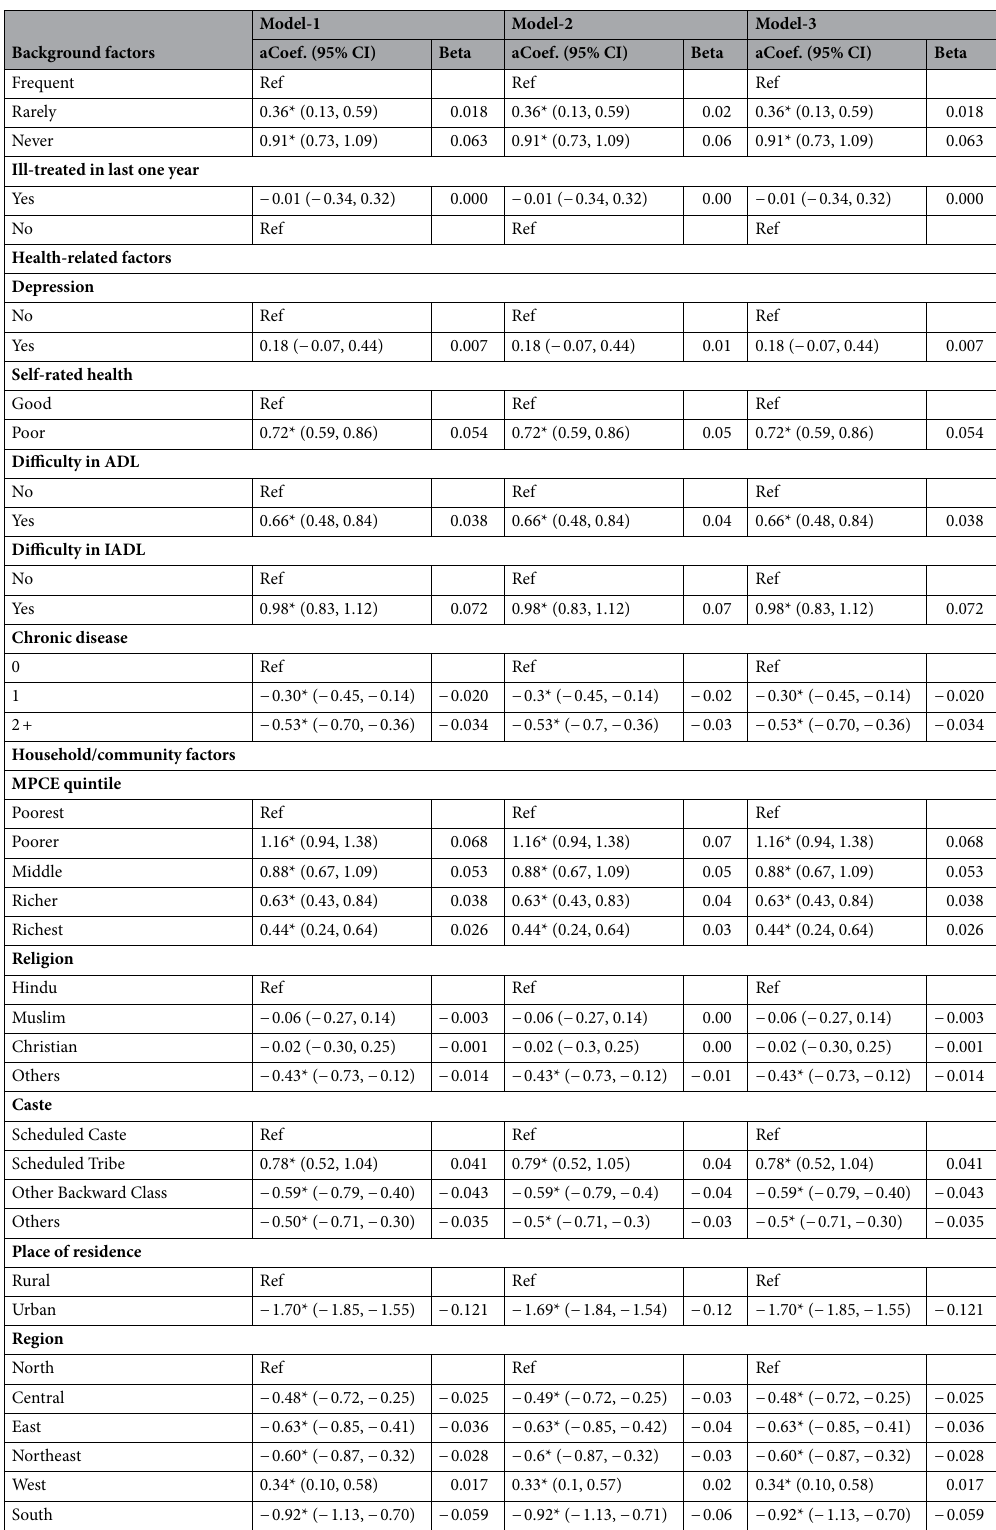
Table 3. Regression estimates of cognitive impairment among older adults by their background characteristics, (n = 24,625). *if p < 0.05; #, Interaction effect; Ref, Reference; CI, Confidence interval; aCoef., Adjusted regression coefficients; Beta, Standardized beta coefficients; ADL, Activities of daily living; IADL, Instrumental activities of daily living; MPCE, Monthly per capita consumption expenditure. The analysis in model-1, model-2 and model-3 was controlled for all individual, health-related and household/community